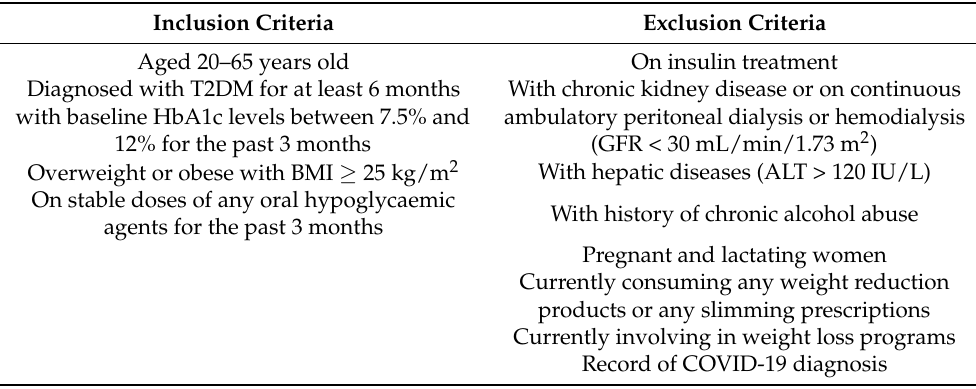
Table 1. Inclusion and Exclusion Criteria. Inclusion Criteria Exclusion Criteria Aged 20–65 years old On insulin treatment Diagnosed with T2DM for at least 6 months with baseline HbA1c levels between 7.5% and Overweight or obese with BMI ≥ 25 kg/m 2 agents for the past 3 months Currently consuming any weight reduction products or any slimming prescriptions Currently involving in weight loss programs Record of COVID-19